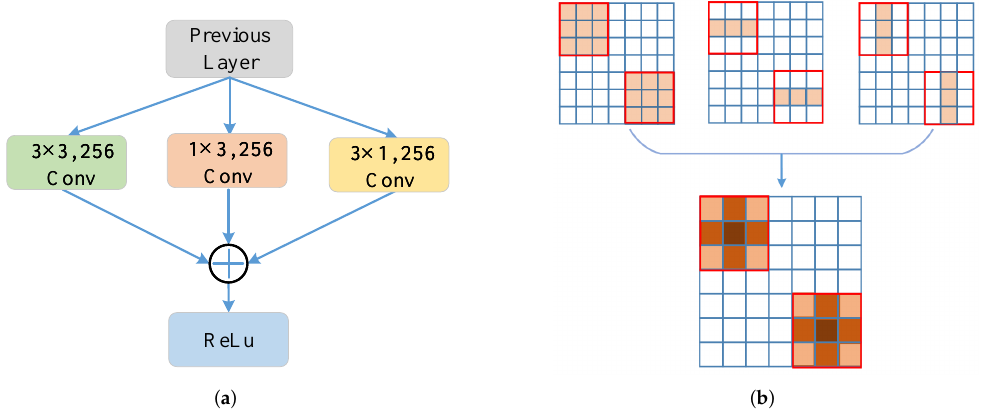
Figure 3. ( a ) The structure of Asymmetric Convolution Block (AC Block) with three parallel convolution layers with 3 × 3, 3 × 1 and 1 × 3 kernels. The ReLu activation is operated on the sum of them.; ( b ) The AC Block focuses on the significance of skeletons feature of ‘+’ shape.